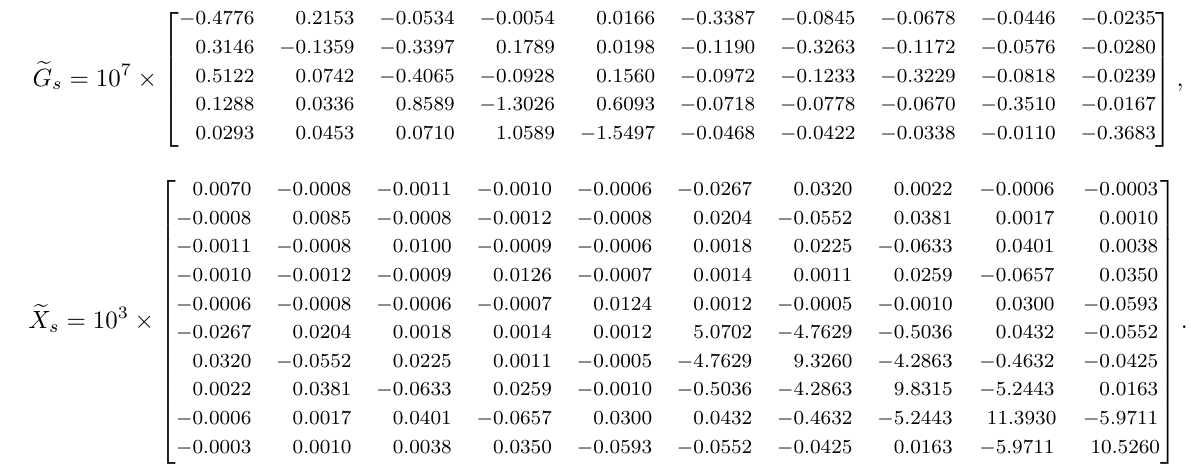
Figure 5: State-feedback gain matrix and X -matrix corresponding to the optimal state-feedback H ∞ controller